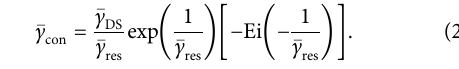
power P t in Figure 4B, where the distance d DS = 500